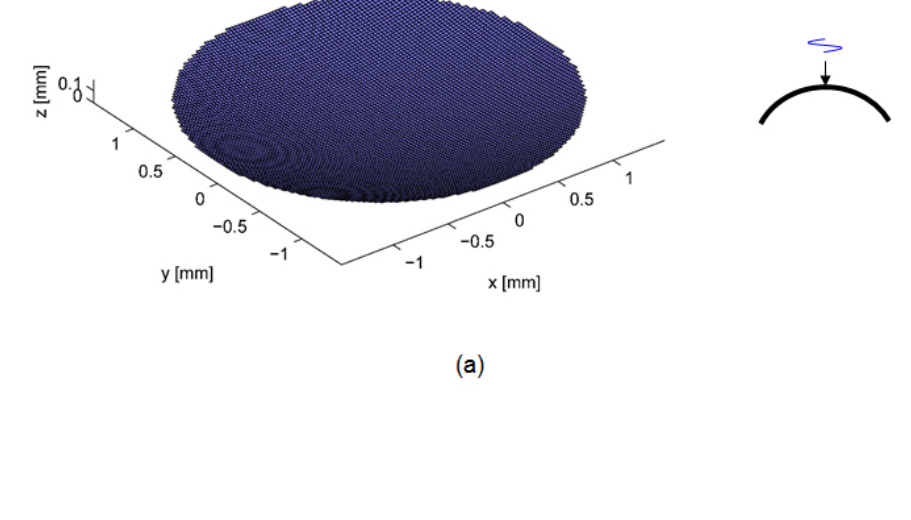
Figure 1. Computed aperture configuration for ( a ) single element transducer and ( b ) dual-element transducer with inverted phase excitation. Right side figures show the applied electrical